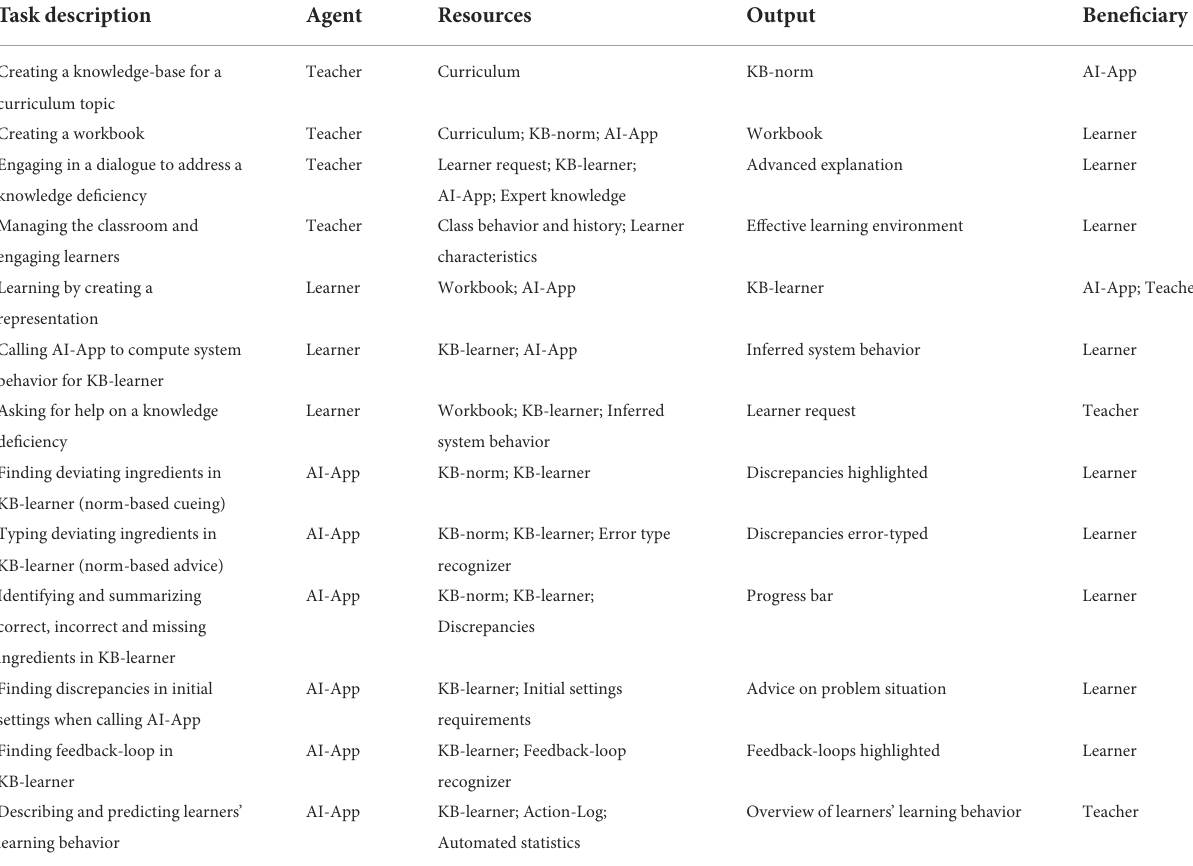
TABLE 2 Summarizing overview of tasks, including task description, the executing agent, the resources used to accomplish the task, the output the task delivers, and the beneficiary who uses the output. Task